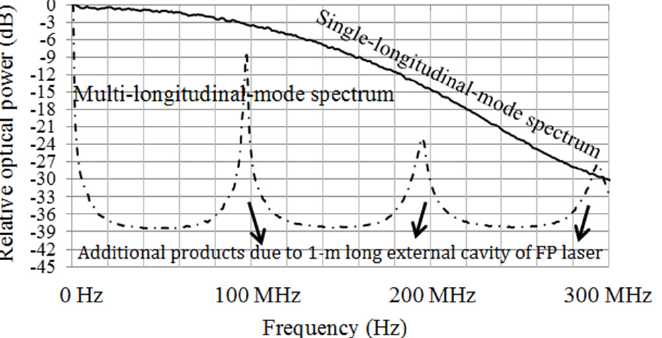
Figure 4. Measured linewidth of master laser and slave laser with an external cavity. Resolution bandwidth: 100 kHz, video bandwidth (VBW): 510 Hz.